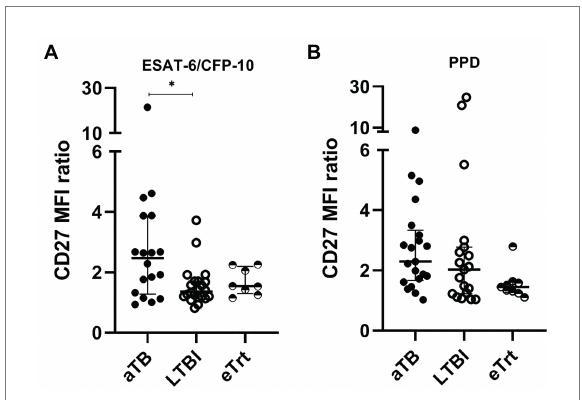
TABLE 2 ROC curve analysis of each marker used in the